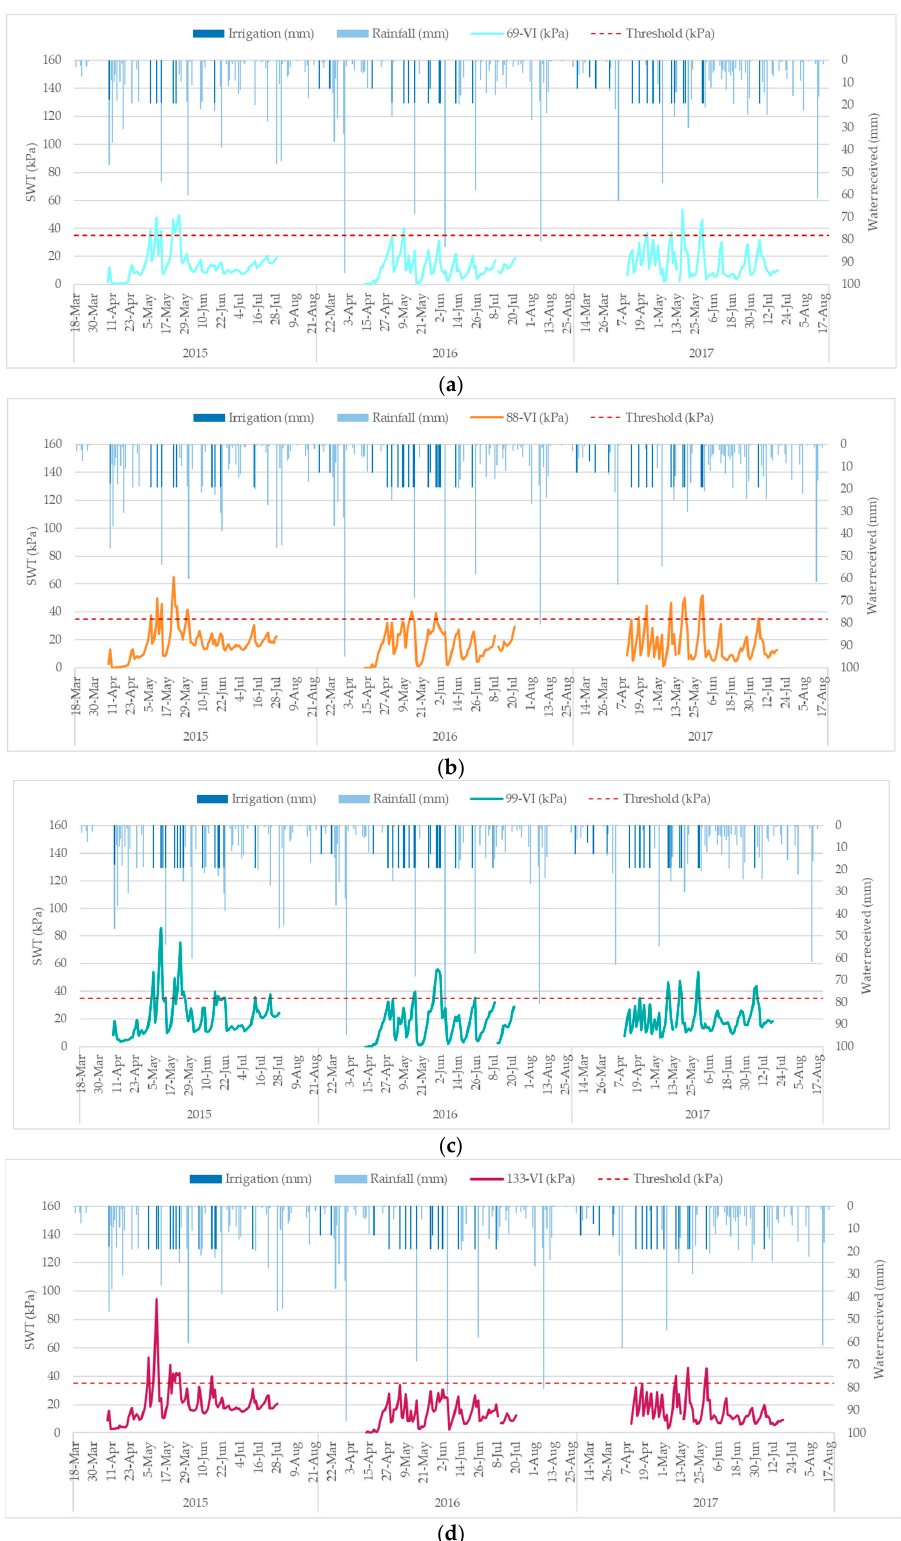
Figure 8. Daily average SWT data for ( a ) 69,000 plants / ha, ( b ) 88,000 plants / ha, ( c ) 99,000 plants / ha, and ( d ) 133,000 plants / ha in conventional tillage and total amount of water received through applied irrigation or rainfall during the 2015, 2016, and 2017 growing